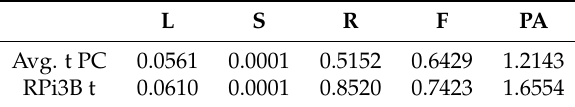
Table 2. PA computing time comparison in